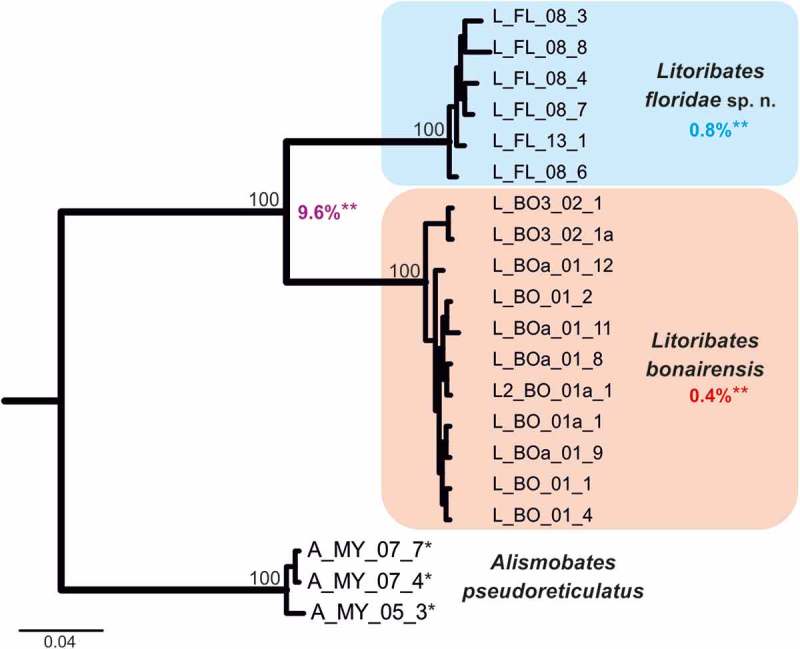
Bayesian inference tree of three fortuyniid species based on COI sequences constructed by means of MrBayes applying the GTR+I+G model. Posterior probabilities for main nodes are shown above branches. Sequences obtained from GenBank are marked by *. For details, see Table 1. ** Mean of intra- (blue, red) and interspecific (violet) uncorrected p-distances given in per cent.